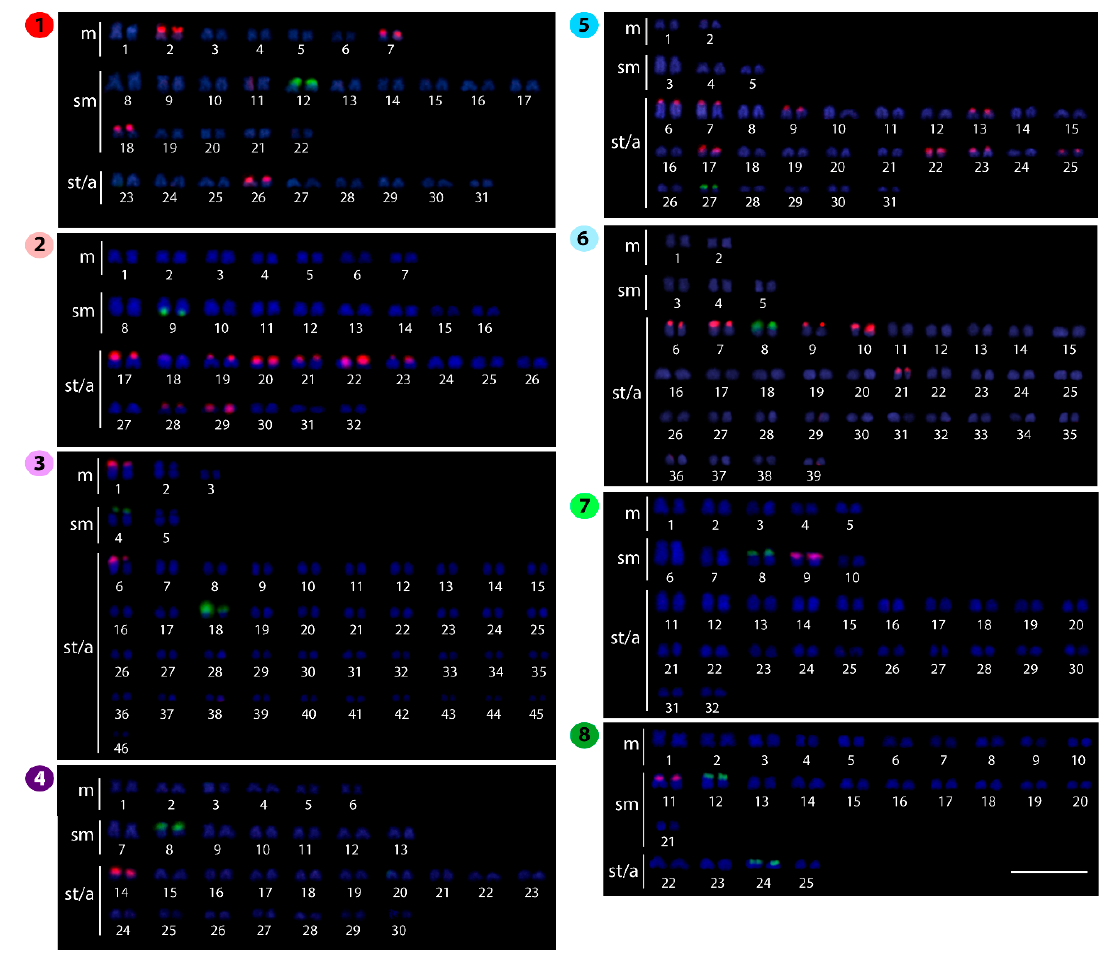
Figure 3. Karyotypes of Belodontichthys truncates ( 1 ); Kryptopterus bicirrhis ( 2 ); Kryptopterus geminus ( 3 ); Kryptopterus limpok ( 4 ); Kryptopterus macrocephalus ( 5 ); Micronema cheveyi ( 6 ); Ompok fumidus ( 7 ); and Ompok siluroides ( 8 ) arranged from chromosomes after double-fluorescence in situ hybridization (FISH) with 5S rDNA (red) and 18S rDNA (green) probes. Bar = 5 µm.